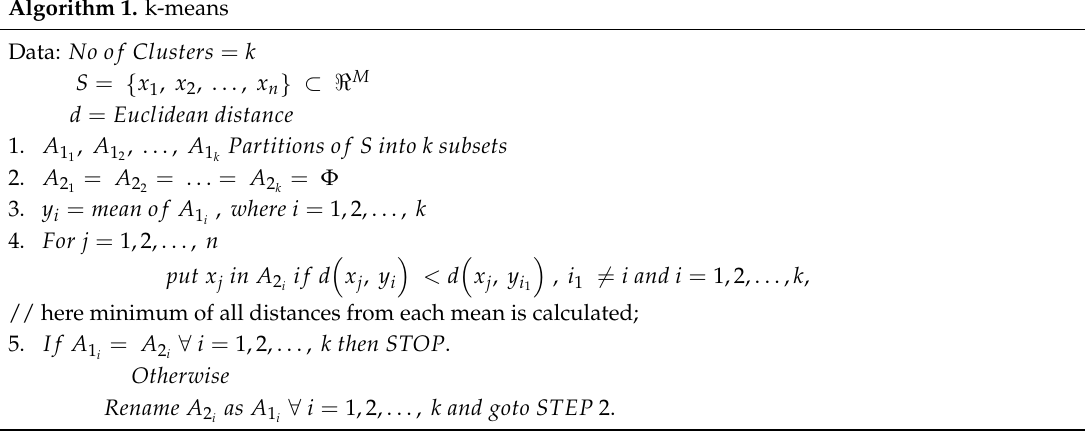
Algorithm 1. k-means